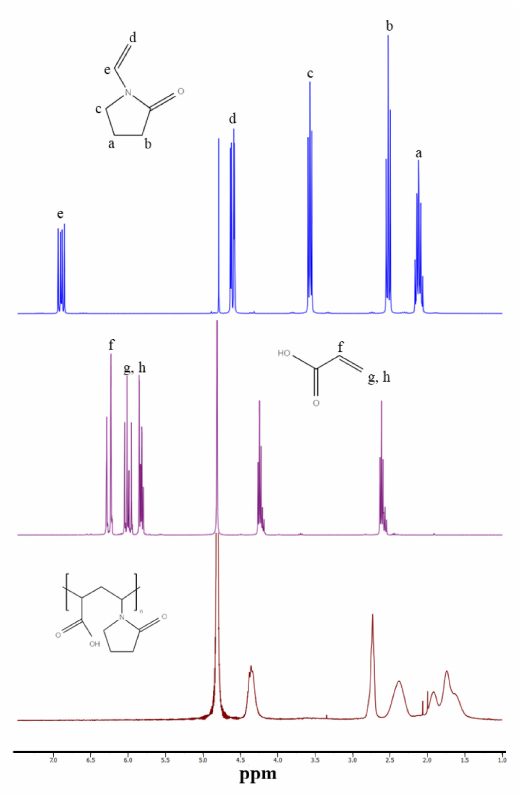
Figure 2. 1 H-NMR Spectra of NVP, AA, and the synthesized